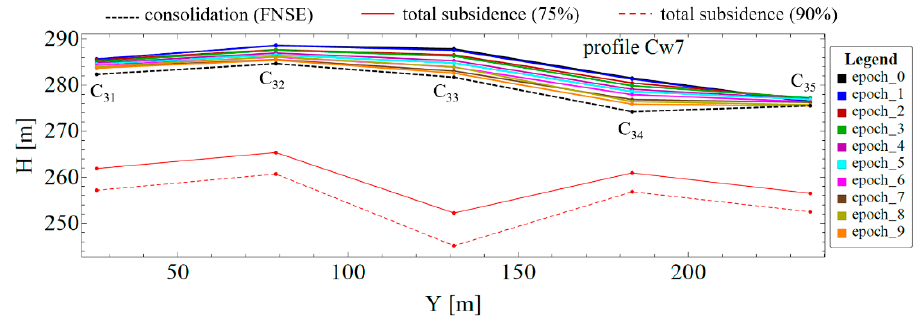
Figure 13. Calculated centroid height by profile Cw7, including height at predicted consolidation (FNSE) and determined 75% or 90% total subsidence.